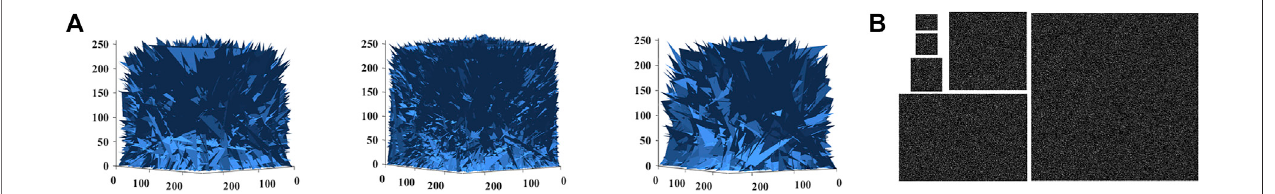
FIGURE 6 | Encryption process key sensitivity (A) 3D models (B) 2D